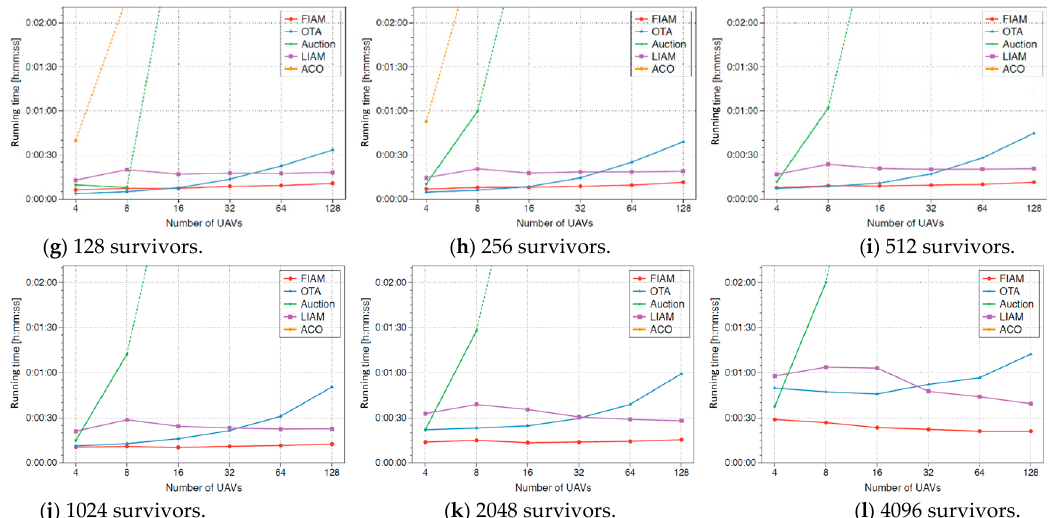
Figure 7. Running time performance as the number of survivors increases from 2 to 4096. ( a ) Running time for 2 survivors. ( b ) Running time for 4 survivors. ( c ) Running time for 8 survivors. ( d ) Running time for 16 survivors. ( e ) Running time for 32 survivors. ( f ) Running time for 64 survivors. ( g ) Running time for 128 survivors. ( h ) Running time for 256 survivors. ( i ) Running time for 512 survivors. ( j ) Running time for 1024 survivors. ( k ) Running time for 2048 survivors. ( l ) Running time for 4096 survivors. UAV, Unmanned Ariel Vehicle; FIAM, fish-inspired algorithm for task allocation in multi-UAV missions; OTA, opportunistic task allocation; ACO, ant colony optimization; LIAM, locust-inspired algorithm for MUTA problem.